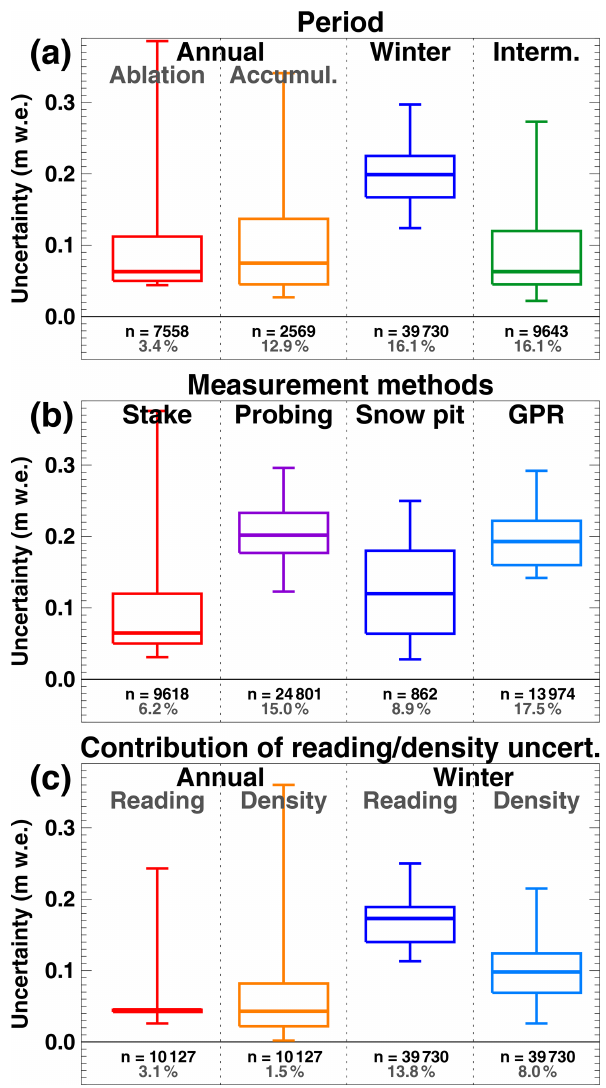
Figure 9. Uncertainty in point mass balance measurements aggre- gated into classes depending on (a) the time period covered, (b) the measurement method, and (c) a separate evaluation of the reading and density uncertainties ( σ reading and σ density , see Eq. 2), both for annual and winter balance. Note that in (a) , ablation and accumu- lation are evaluated separately for the annual period. Boxes refer to the 25% and the 75% percentile and bars encompass a 95% inter- val. The bold horizontal line shows the median. The number ( n ) of evaluated points is given and the average share of the uncertainty relative to the point’s mass balance is stated in